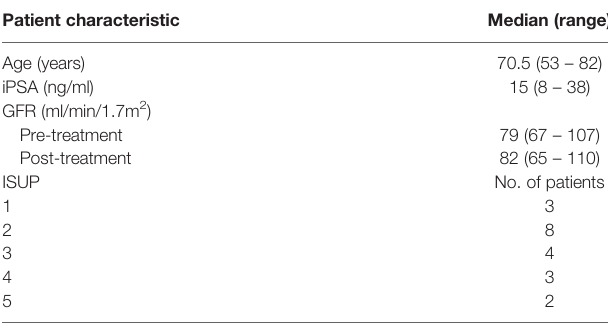
TABLE 1 | Patient